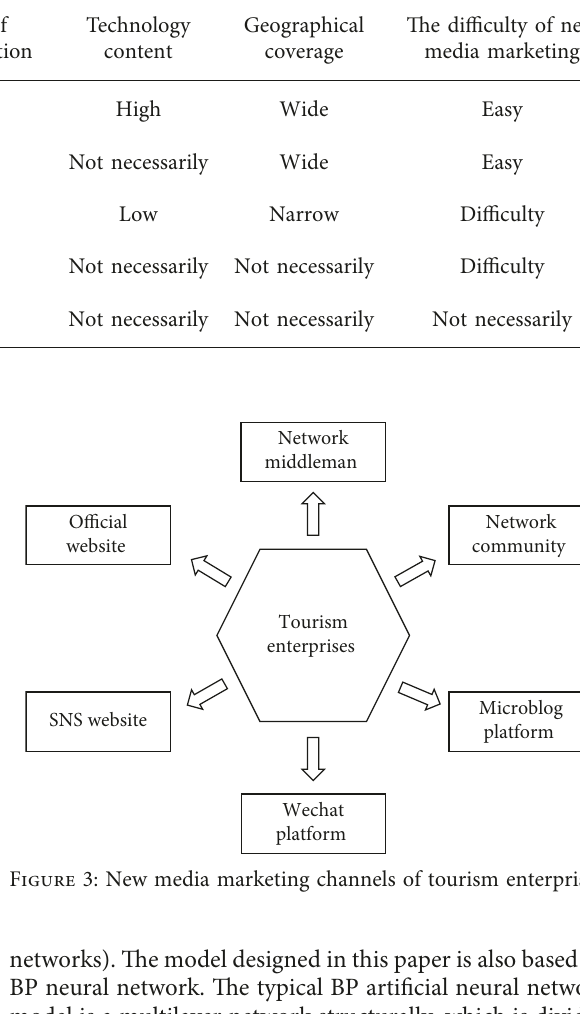
Table 3: Comparison of marketing characteristics of tourism